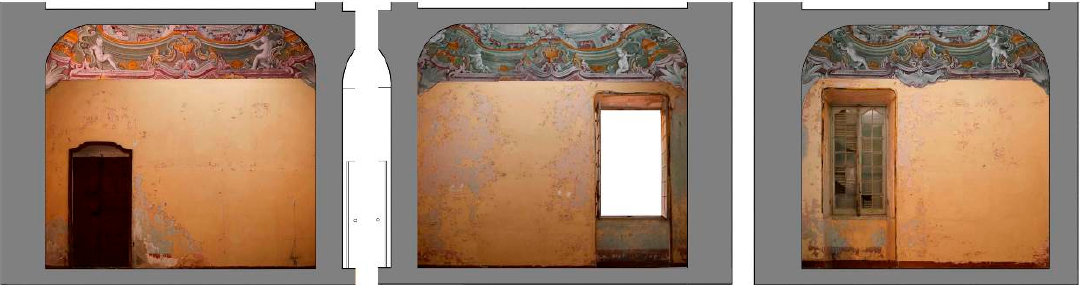
Figure 8. Survey carried out for the first room.